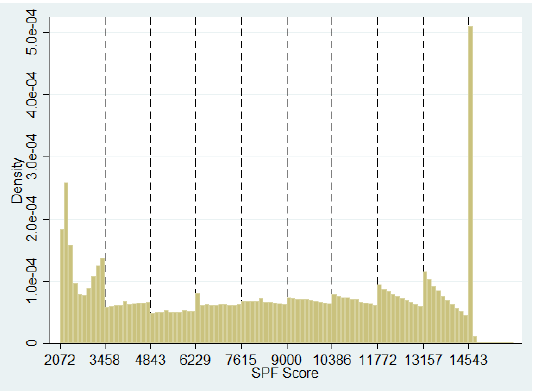
Figure 4: Social Protection File Scores Distribution (Year 2011)